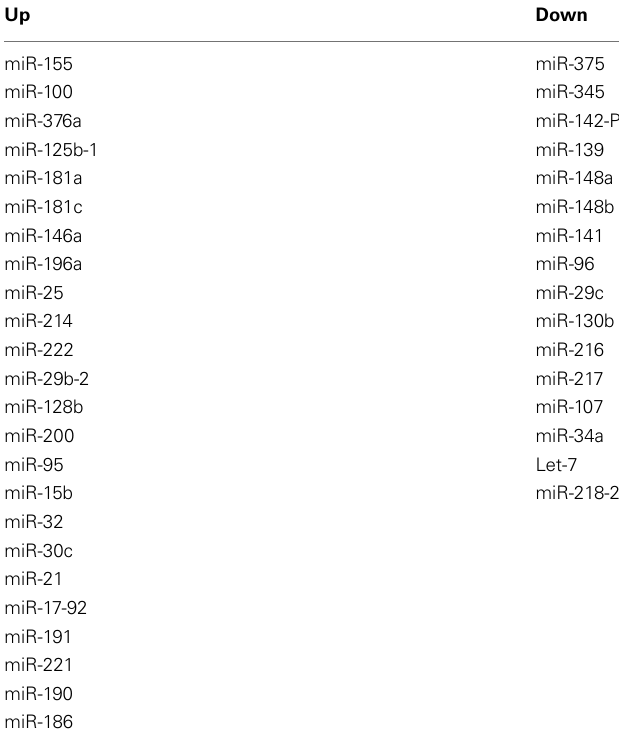
Table 2 | microRNAs frequently misregulated in pancreatic